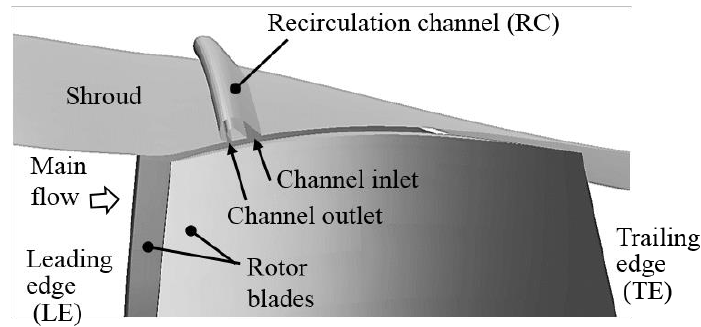
Figure 1. The concept of the recirculating type casing treatment over the rotor blade tip clearance.